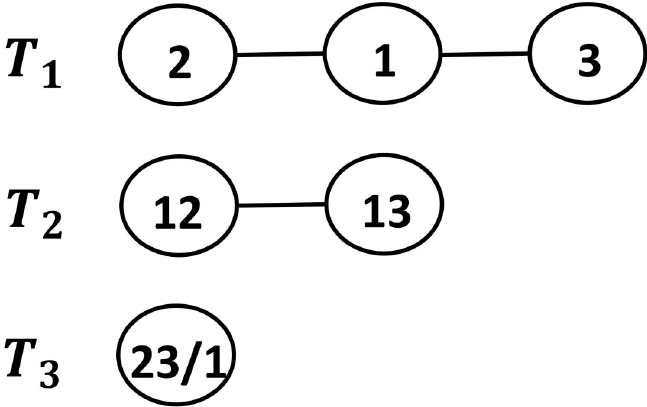
Fig 1. R-vine copula with 3 stocks. T 1 , T 2 , T 3 corresponds to trees 1, 2 and 3 respectively.